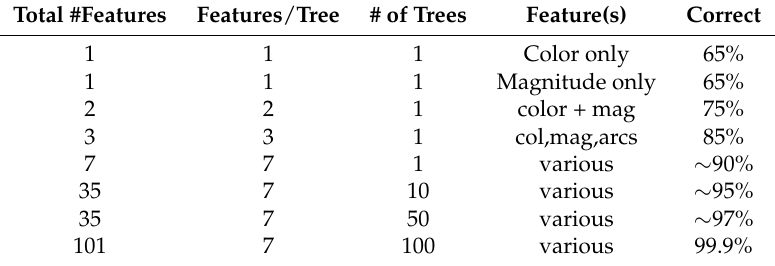
Table 4. Illustration of how the results of the classification improve as we allow more complex trees, and larger forests. The lines in which the feature(s) are listed as “various” means that, choosing k features ( k from the first column), it is not difficult to find k features that provide a correctness similar to the last column. Of course not every selection of k features will result in that correctness; correctness was enhanced when the feature set included at least some high-quality features (cf. Section 3.3).